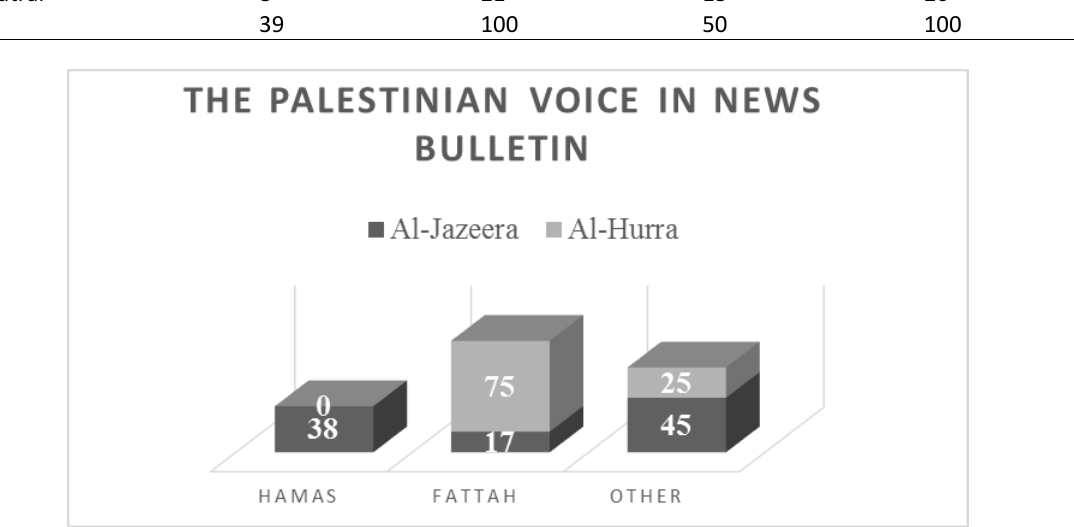
Figure 3. The Palestinian voice in news bulletins